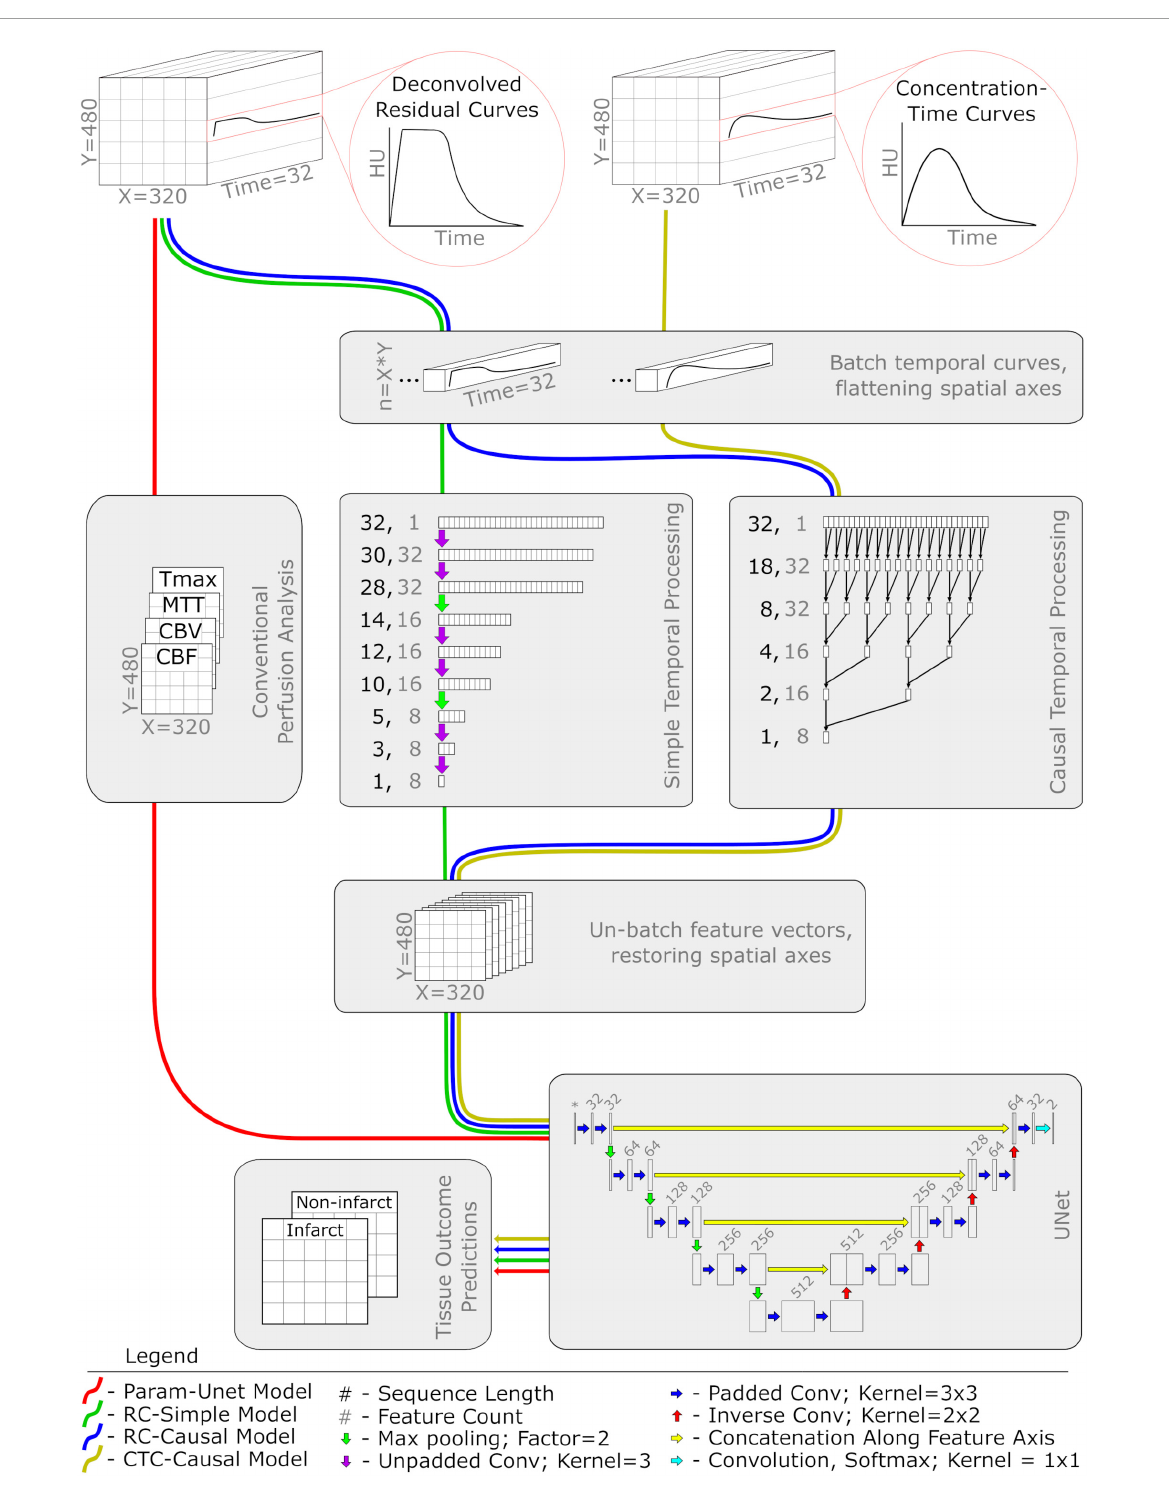
FIGURE1 Network diagram of the four deep learning classifiers used in this study. Each colored pathway illustrates the flow of information for a different model. Abbreviations and acronyms are as follows: CTP, computed tomography perfusion imaging; CBF, cerebral blood flow; CBV, cerebral blood volume; MTT, mean transit time; Tmax, time to maximum of the residual curve; conv,